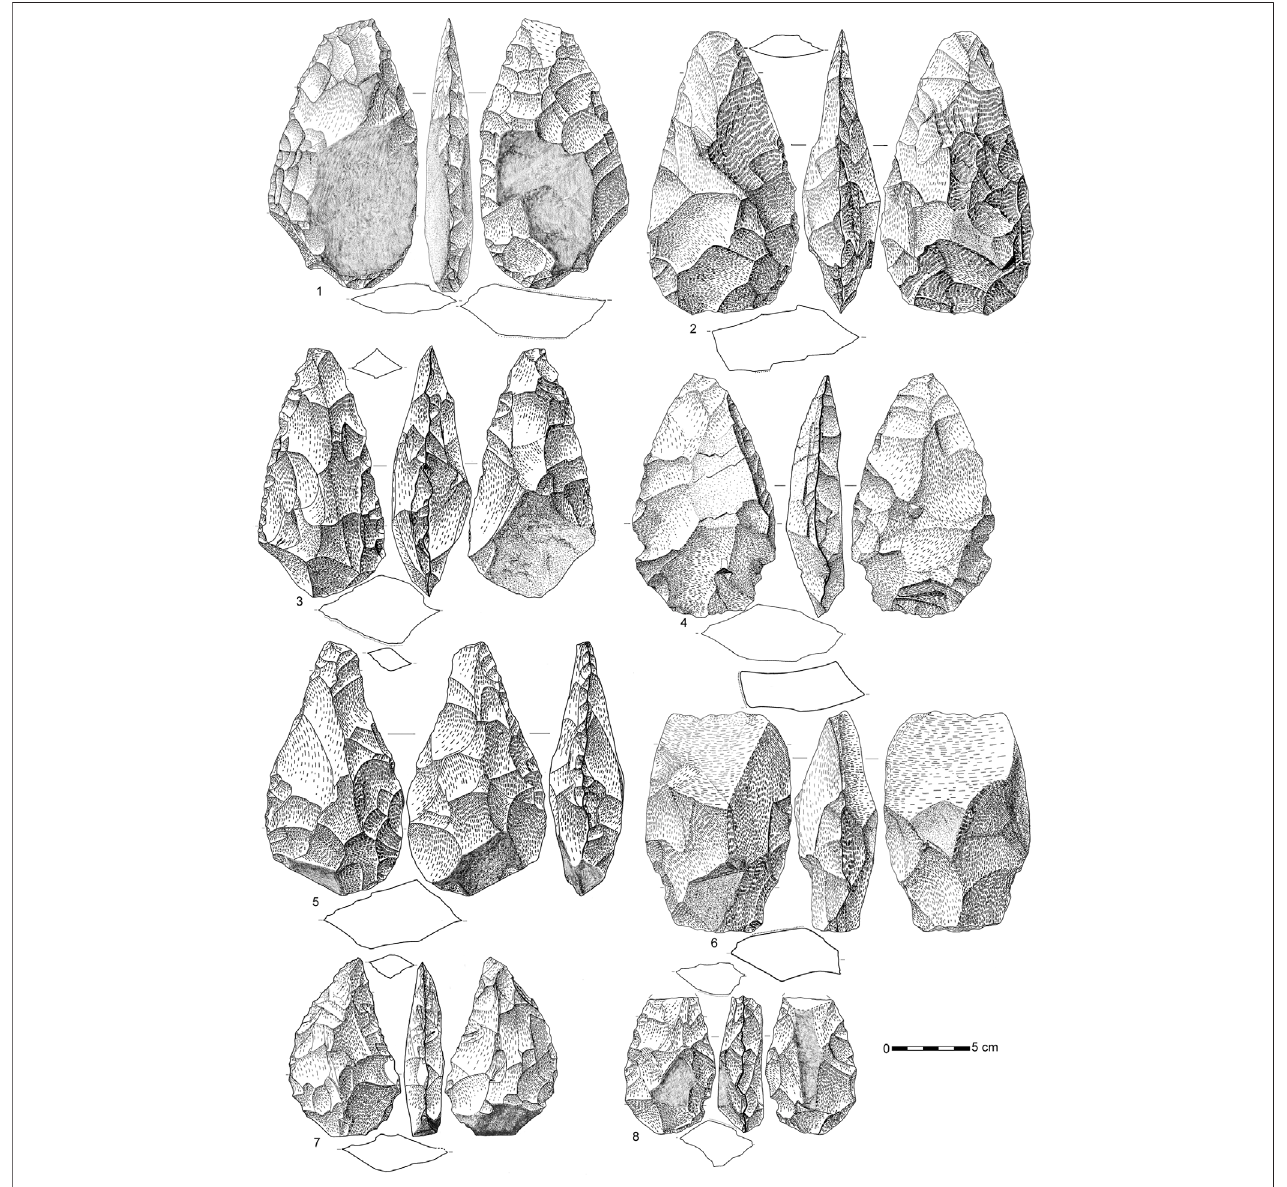
FIGURE9| Handaxes.Lanceolate(one tothreeand 8), amygdaloid (4and 5), transverse cutting edge(6),and subtriangular(7).Quartzite (1-6and 8)and chert (7).